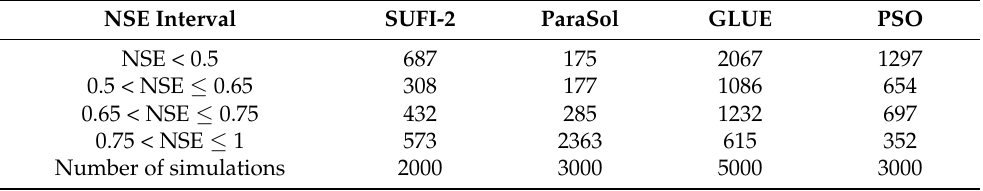
Figure 5. Frequency distribution of different Nash–Sutcliffe efficiency coefficient (NSE) values using the SUFI-2, ParaSol, GLUE, and PSO methods in the whole period (1975 to 2004). Table 5. Frequency of runoff simulation results obtained by four methods in different NSE